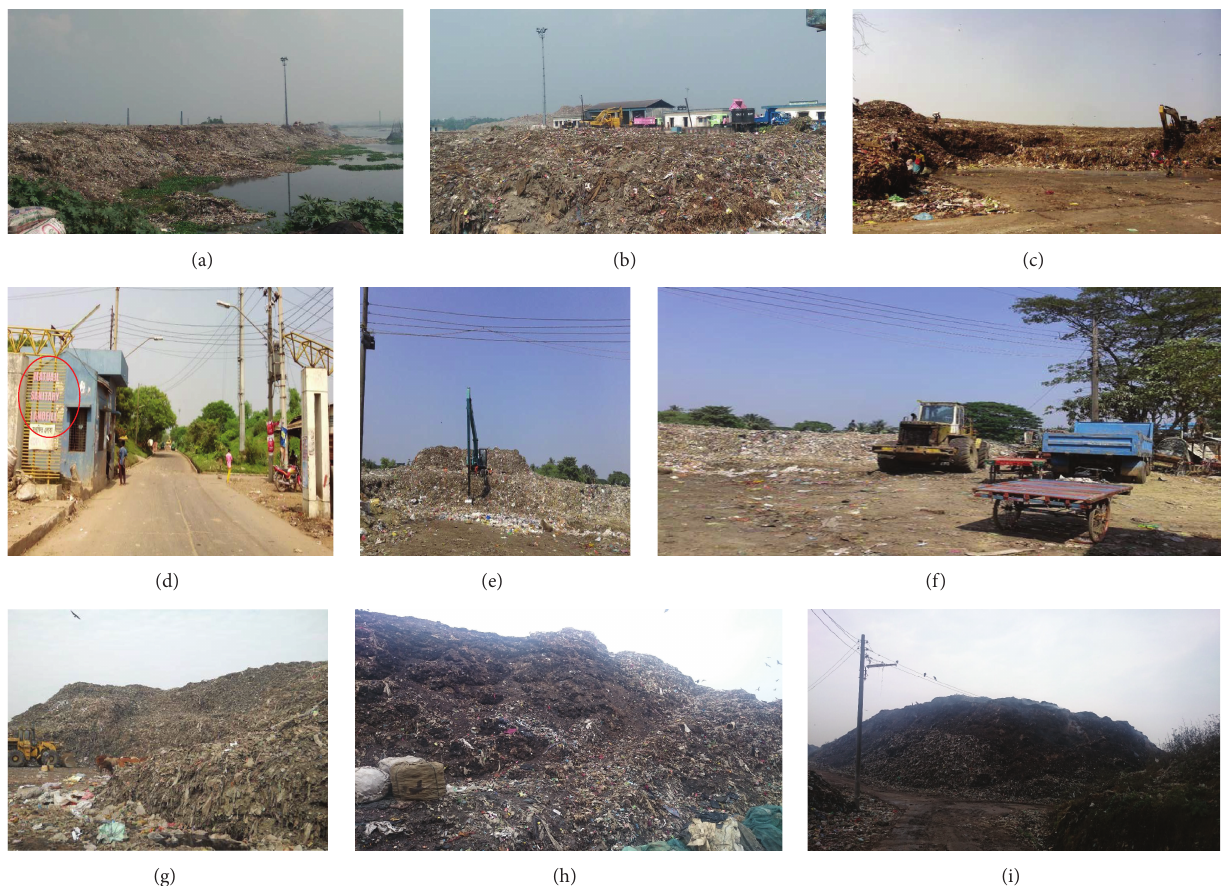
Figure 2: MSW disposal site in Dhaka and Chittagong city. (a-b) Amin Bazar and (c-d) Matuail dumping site in Dhaka; Matuail open dumping sites named as sanitary landfill (red circle in (d)), with the aim of converting it to sanitary landfill site in the future, but open dumping is practiced now. Kalurghat open dumping sites (e-f) and Ananda Bazar open dumping sites (g–i) in Chittagong.